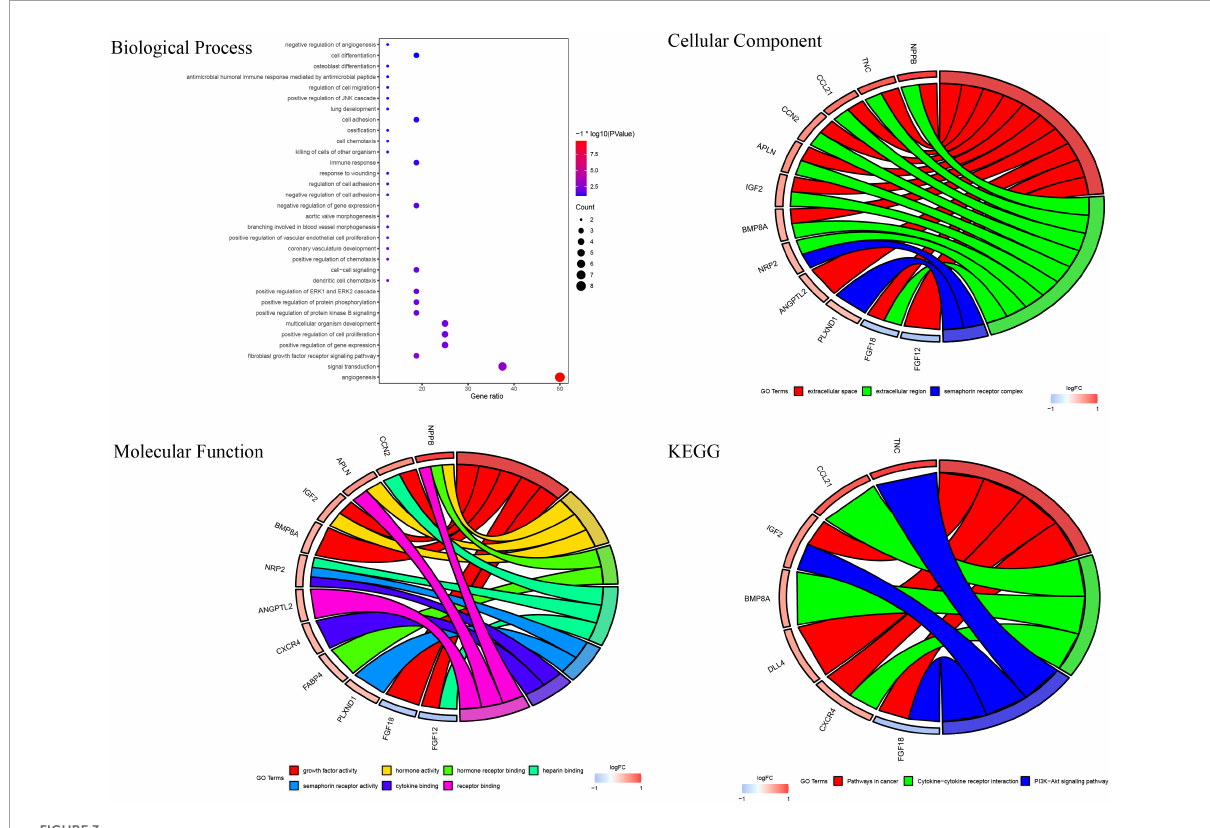
FIGURE3 GO and KEGG enrichment analysis of immune related